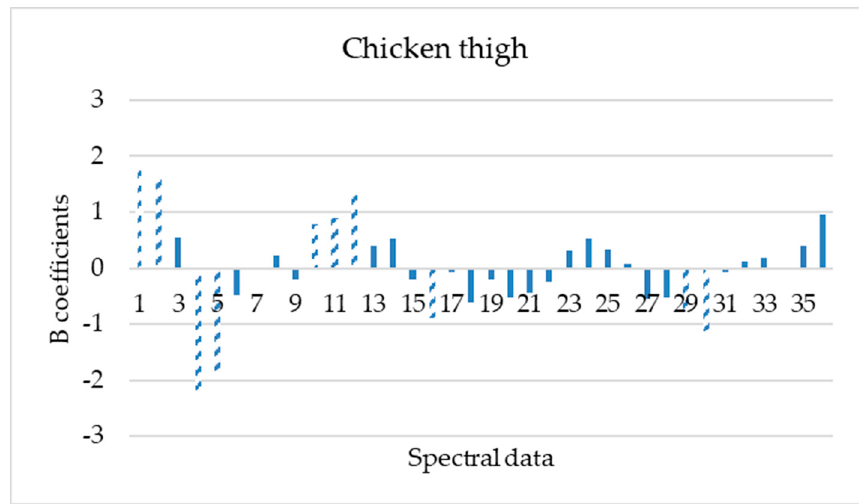
Figure 5. Spectral data (mean and standard deviation) influence (b coefficients) to PLS-R model construction for chicken thigh samples. Dashed bars represent data that influenced more the model